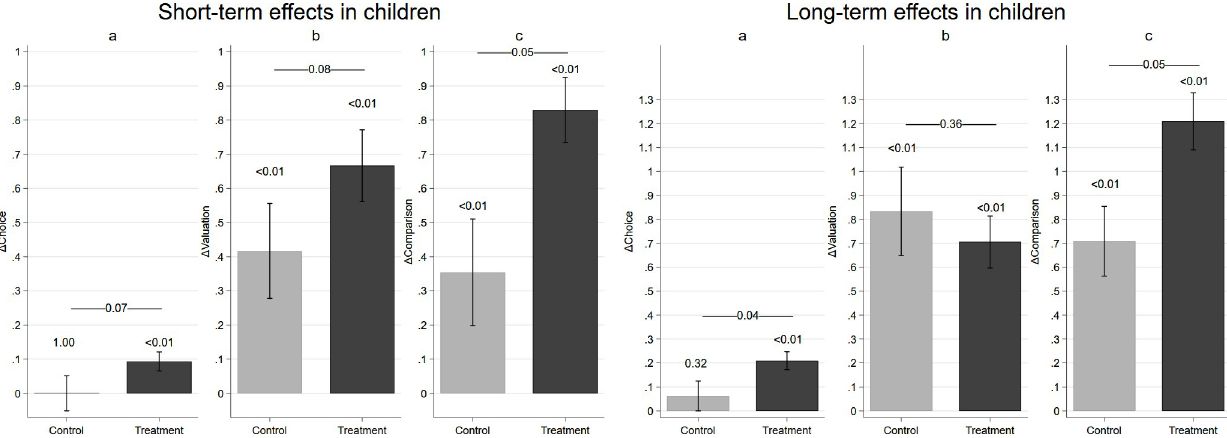
Fig 1. Short- and long-term effects of the treatment. Left panel displays the estimates for the second assessment (short-term effect) for treated and untreated children. Right panel displays the estimates for the third assessment (long-term effects) for treated and untreated children. The bars represent the linear predictions from OLS for the three valuation measures.–a. choice: proportion of children choosing the dried apple, b. liking: liking of the dried apple measured on a 4-point scale, and c. comparison: number of times the dried apple is preferred in 5 pairwise comparisons. P-values of group differences are reported above the bars. Standard errors are clustered on the class level. The full models are presented in S3 Table. Data are presented as mean/ proportion ± 95% CIs. While the concept of evaluative conditioning would not make a clear prediction about the differences between the two treatment groups, the theory of effort justification predicts that children who must provide high effort should increase their valuation more, relative to those who only have to provide low effort to receive the food reward. To investigate whether this is the case, we compare the increase in valuation between the two effort treatments by estimating linear regression models including a variable for ‘high effort treatment’. This coefficient corresponding to this variable should capture any differential effect between the two treatment groups. We find a small and not statistically significant estimated coefficient in most regressions. For the c omparison measure, contrary to the predictions of effort justification, we find a negative differential effect in the short-term ( n total = 177, main effect: B = 0.57, SE clustered = 0.12, t = 4.57, P < 0.01; high effort: B = -0.25, SE clustered = 0.12, t = -2.07, P = 0.07; see S7